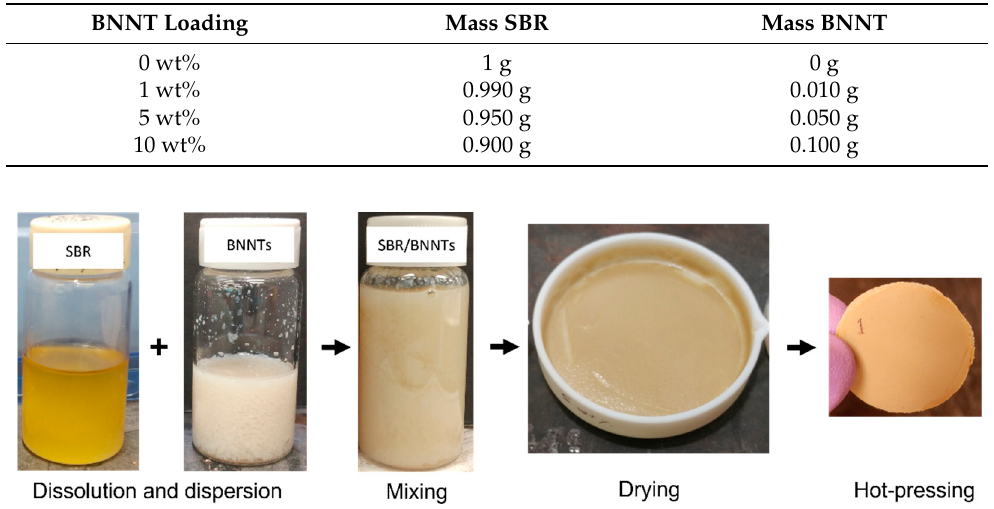
Figure 1. Methodology followed for the fabrication of SBR/BNNTs nanocomposites.